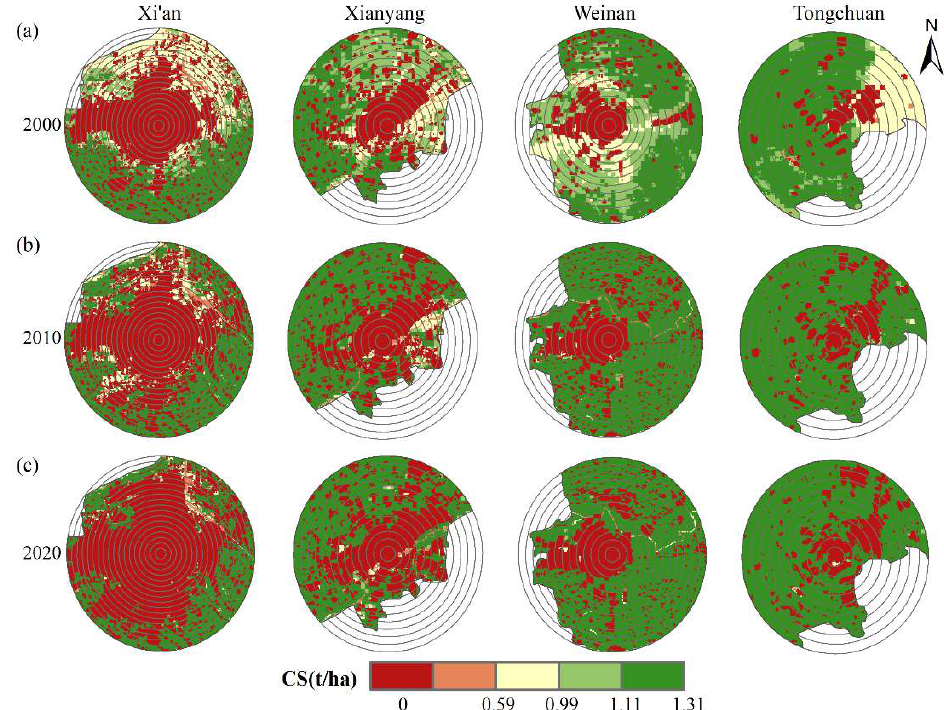
Figure 5. Spatio-temporal dynamic maps of carbon sequestration (CS) in ( a ) 2000, ( b ) 2010, and ( c ) 2020 in the XMA (unit: t/ha).